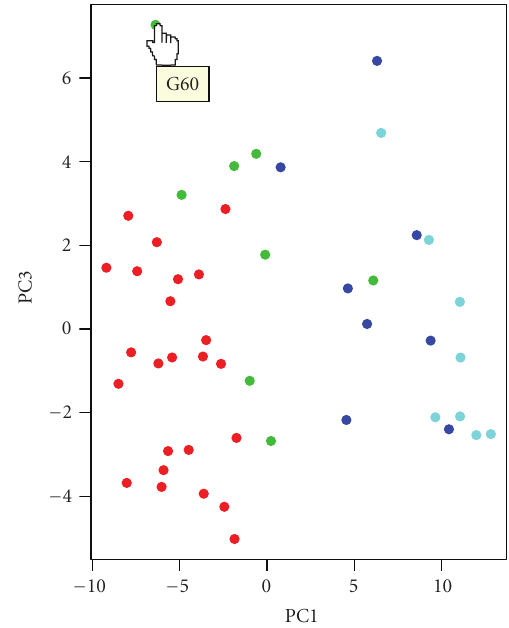
Figure 4: Examples for output generated by meta P- server : PCA plot colored by